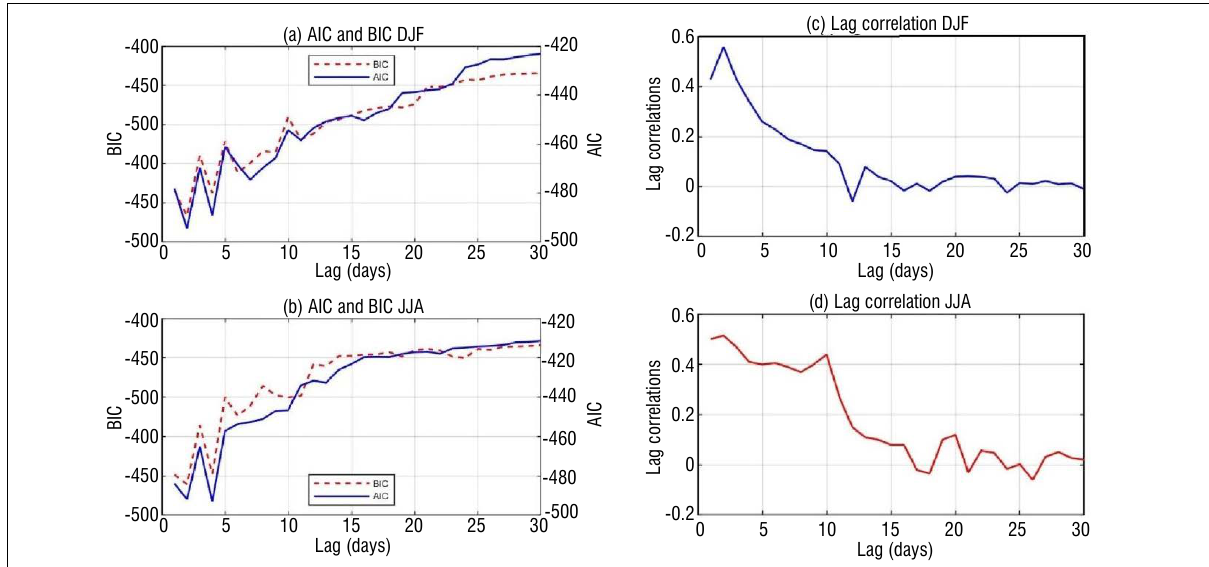
Figure 7: (a,b) Akaike information criterion (AIC, blue solid line) and Bayesian information criterion (BIC, red dashed line) values for (a) December–February (DJF) and (b) June–August (JJA); and (c,d) lag correlations for (c) DJF and (d)